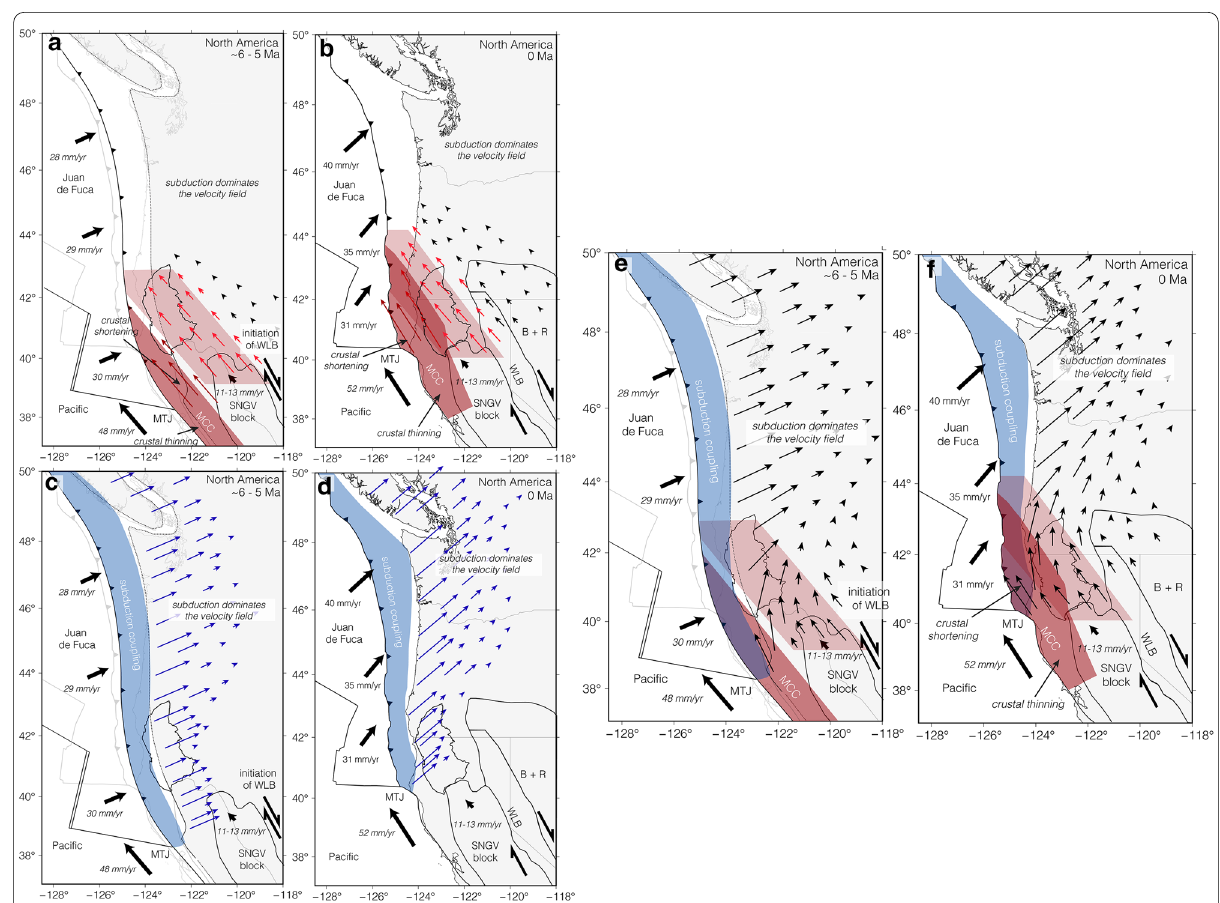
Fig. 5 Paleo-reconstruction of the plate boundary system across Cascadia, including the region south of the MTJ using finite rotation poles from DeMets and Merkouriev (2016) and Wilson (1993)—the methodology is described in the supporting material. The paleo-shorelines shown in the ~ 6–5 Ma reconstructions are interpolated from Lock et al. (2006). a ~ 6–5 Ma reconstruction showing the approximate location of the MCC and SNGV deformational footprints and a schematic paleo-(NNW component)-GPS field based on reconstructed plate motions. b Present-day map of the Cascadia plate boundary system showing the approximate location of the MCC and SNGV deformational footprints (based on results from this study) and a schematic of the observed NNW component of the GPS field. c ~ 6–5 Ma reconstruction showing the approximate location of the subduction-related deformational footprint and a schematic paleo-(subduction component)-GPS field based on reconstructed plate motions. d Present-day map of the Cascadia plate boundary system showing the approximate location of the subduction coupling deformational footprints and a schematic of the observed subduction component of the GPS field. e ~ 6–5 Ma reconstruction showing the approximate location of the subduction, MCC and SNGV deformational footprints and a schematic total paleo-GPS field based on reconstructed plate motions. f Present-day map of the Cascadia plate boundary system showing the approximate location of the subduction, MCC and SNGV deformational footprints and a schematic of the observed total GPS